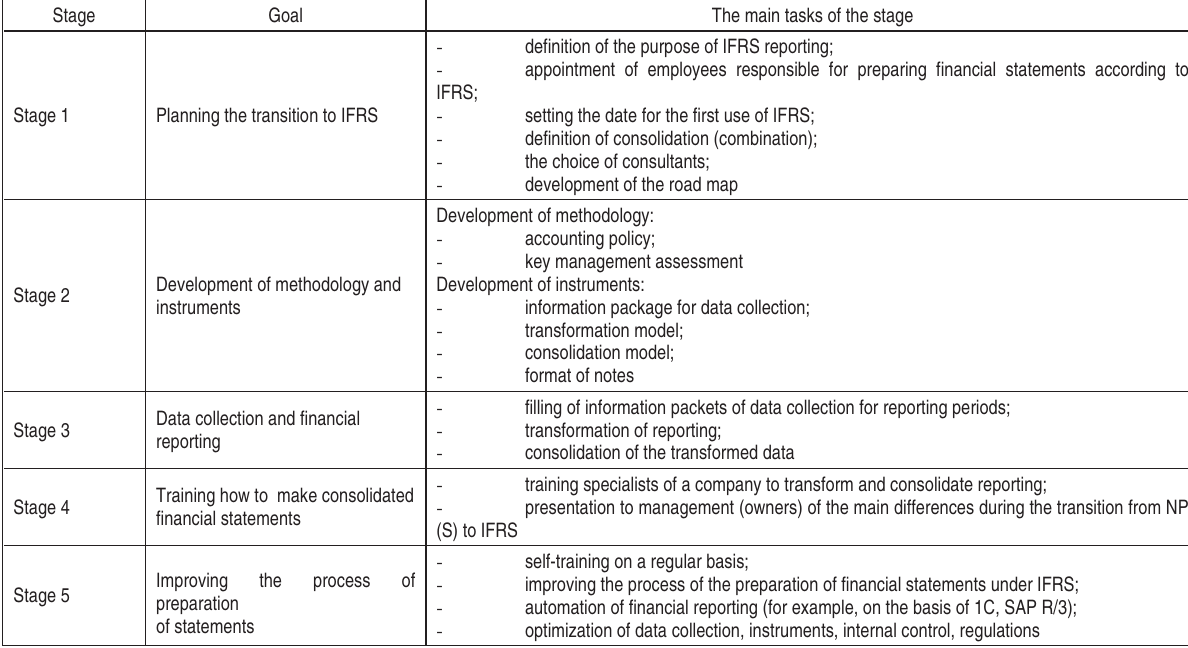
Table 2. Stages of transition to IFRS